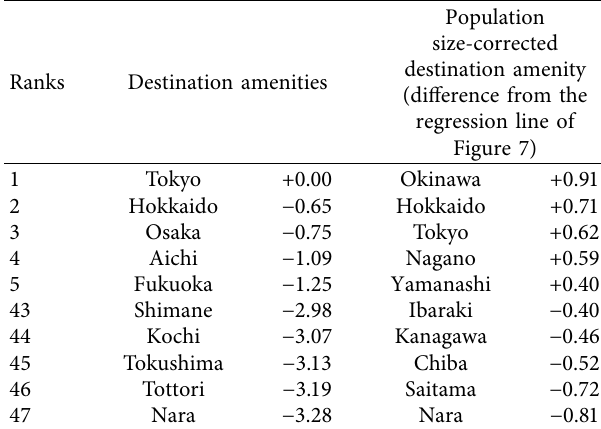
Table 1: Rank of destination